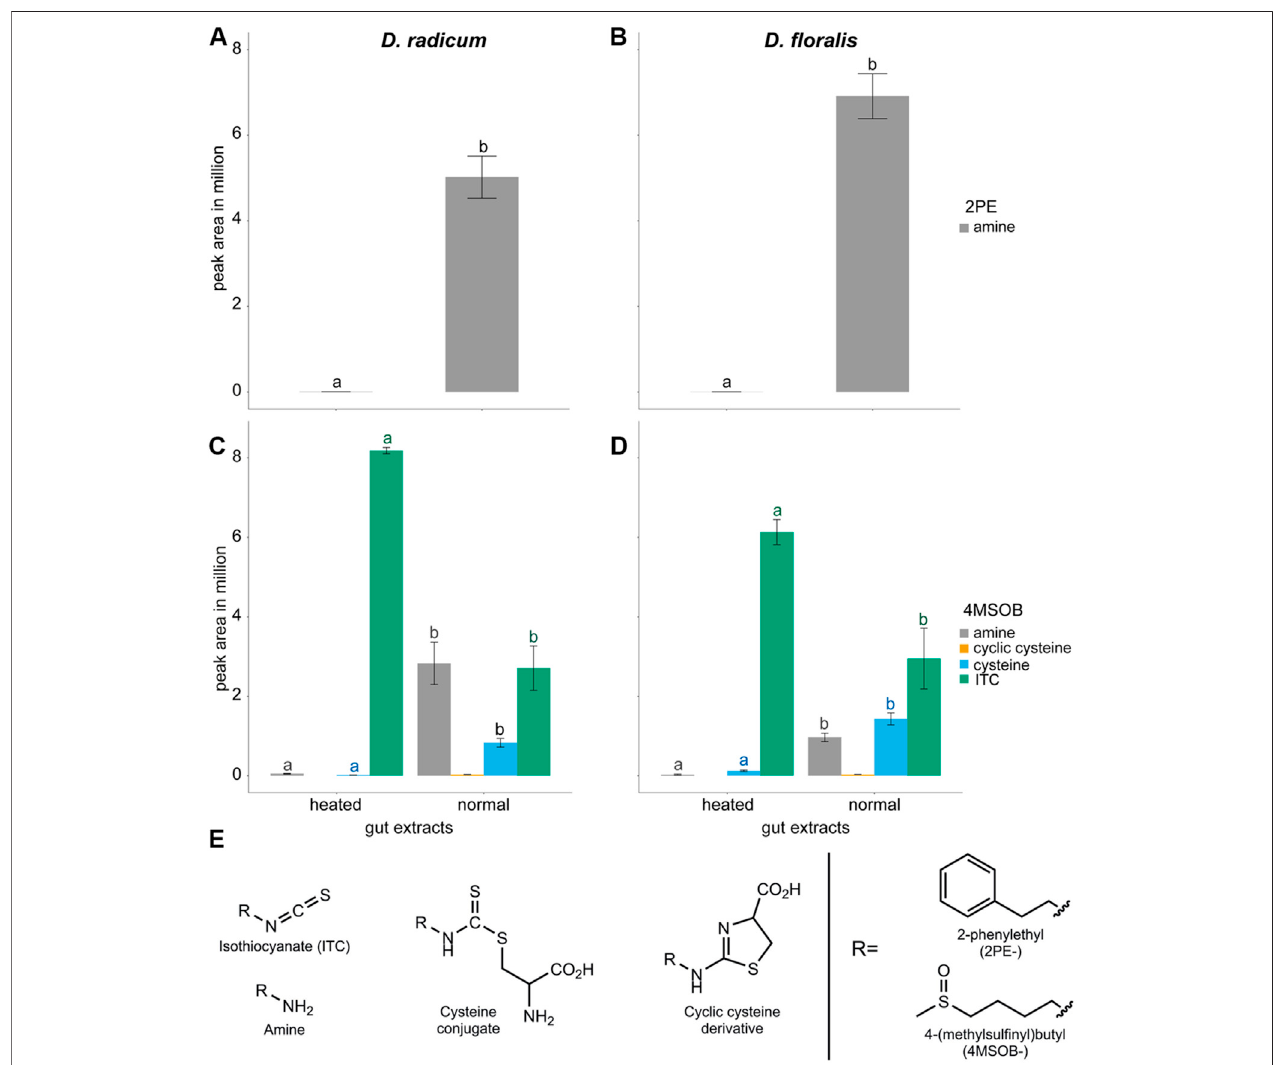
FIGURE 2 | Isothiocyanates (ITCs) and products formed after metabolism by gut extracts from Delia radicum (left) and D. fl oralis (right) larvae. (A) Blank corrected peak areas of 2-phenylethylamine (PE-amine) formed as a product of 2PE-ITC added to gut extracts of D. radicum and (B) D. fl oralis larvae. (C) Blank corrected peak areas of 4-(methylsul fi nyl)butyl-ITC (4MSOB-ITC) and products formed after 4MSOB-ITC was added to gut extracts from D. radicum and (D) D. fl oralis larvae. (E) Structuresofcompoundsdetected in D. radicum and D. fl oralis gutextracts exposed toITCs.Gutswere extracted and incubated at room temperature(normal) or heated before adding 50 µMol 4MSOB-ITC or 2PE-ITC and incubated for 1 h at room temperature. Each condition was represented by three biological replicates consisting of 10 larval guts. The blank corrected peak areas of each compound were compared between conditions using one-way ANOVA and Tukey post-hoc. Different letters indicate signi fi cant differences for each compound (same color for same compound) between the groups within one species ( p < 0.05).